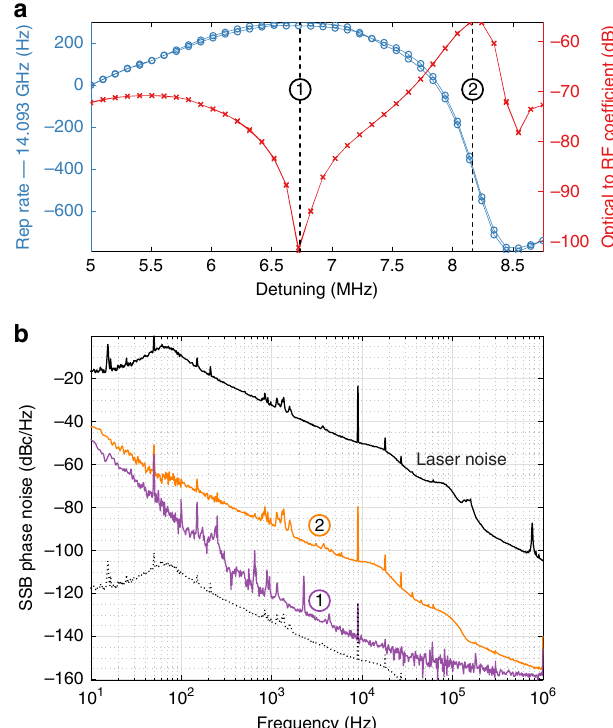
Fig. 5 Quiet operating point. a Evolution of the repetition rate with the detuning (blue) and associated optical phase modulation to RF phase modulation conversion coef fi cient calibrated with the 9-kHz phase modulation tone on the laser (red). b Phase noise spectra of the soliton repetition rate at the two operating points highlighted in ( a ). The solid black line shows the laser noise (PDH-stabilised to the microcavity). The dashed black line shows the noise of the laser scaled by − 100 dB to match the 9-kHz phase calibration tone.